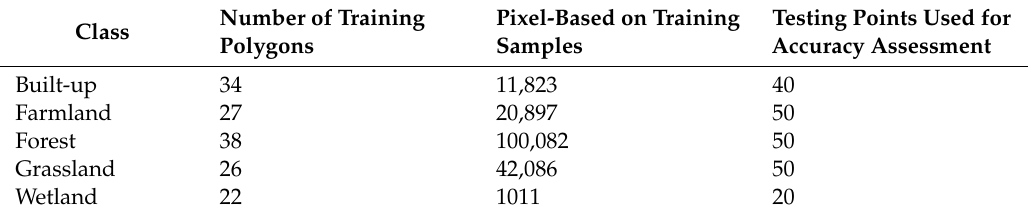
Table 4. Training polygons, samples and testing points for year